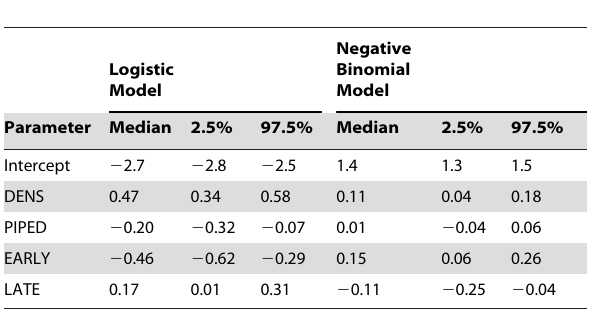
Table 2. Population level parameters estimates and their confidence intervals for the hurdle regression model.